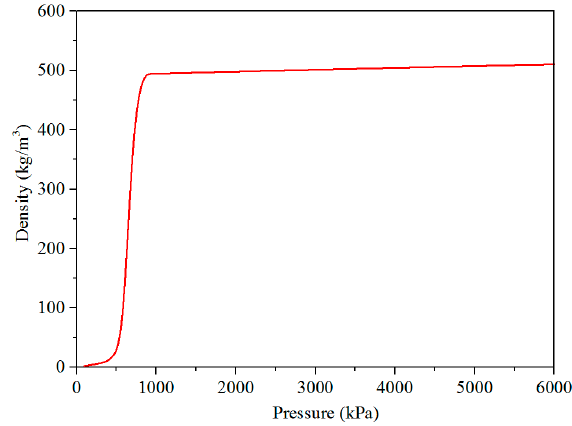
Figure 11. The NGL density at 290 K.